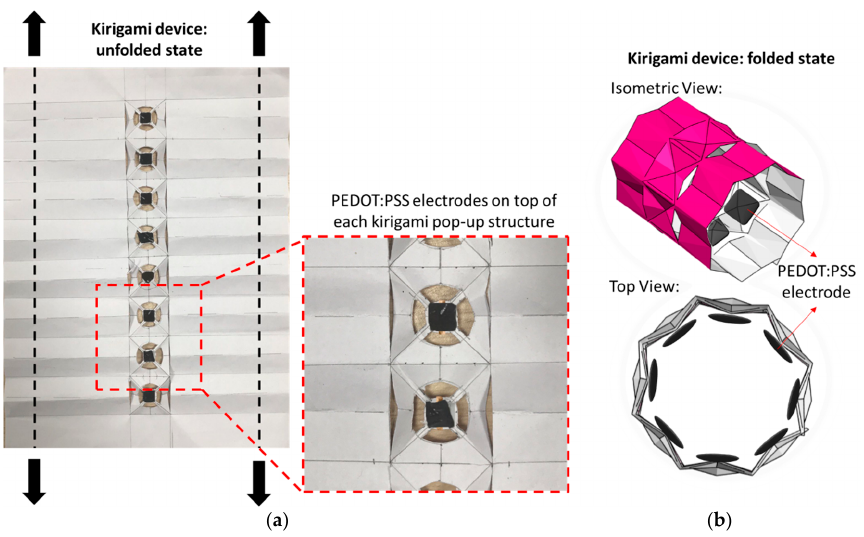
Figure 2. ( a ) Proposed kirigami-based bracelet in the unfolded state. Inset shows electrode placement with the help of thin strips of double-sided copper tape over the flat platform. The black dotted lines represent the string, and the small black arrows denote the direction in which they must be pulled in order to tighten the prototype around the arm. ( b ) Simulated model of the proposed kirigami bracelet in the folded state. The PEDOT: PSS electrodes are projected inward towards the skin of the arm to establish electrical contact for measuring skin